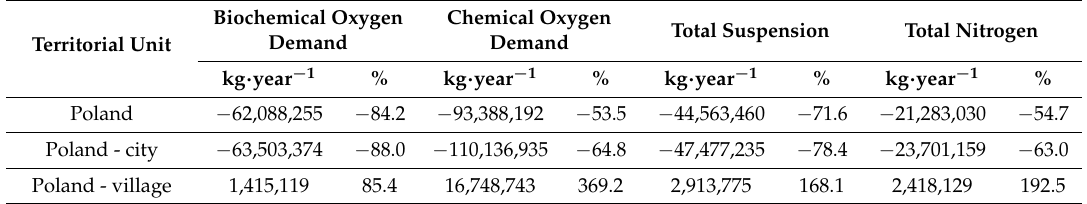
Table 3. Change in pollution loads in treated sewage, 1998–2017.